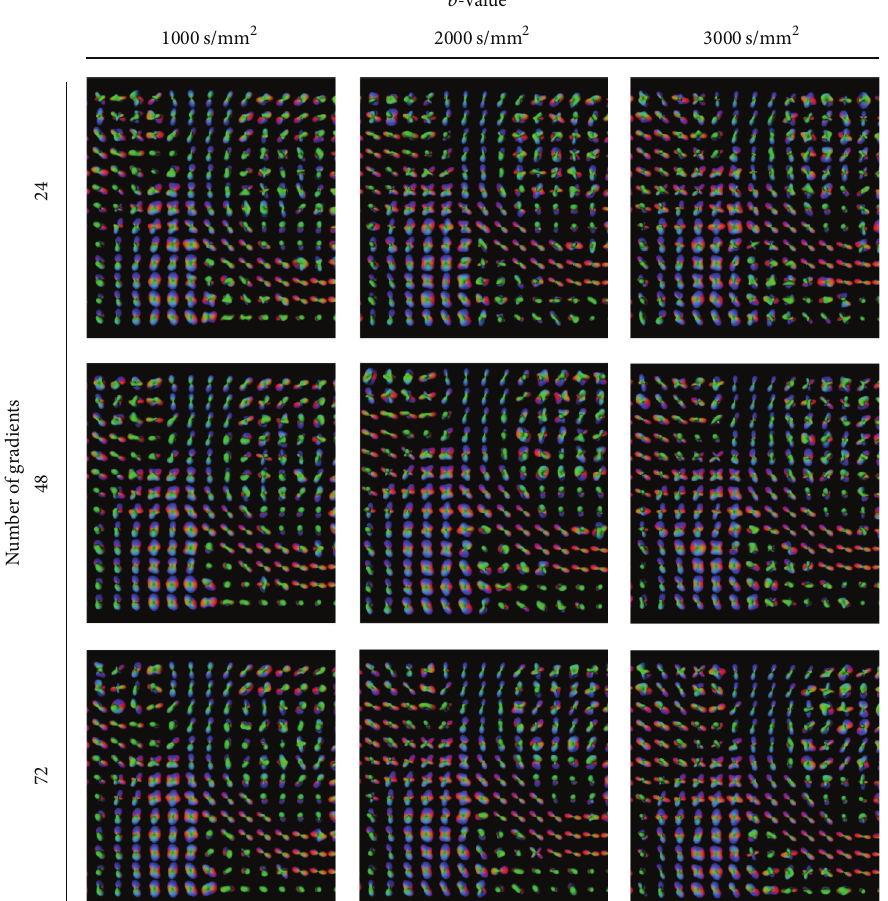
Figure 12: The effect of the 𝑏 -value and the number of gradients at 𝑙 = 4 . Conclusions are similar to Figure 11, however, at order ℓ = 4 it is more difficult to spot the threefold